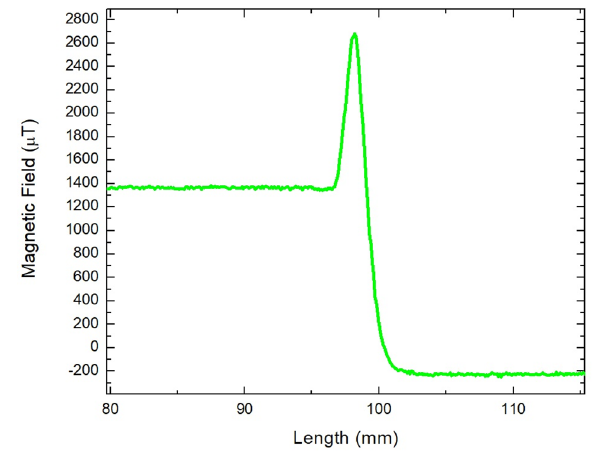
Fig. 16 Experimental result of magnetic field X of a rectangular defect B1 with ordered magnetic domains